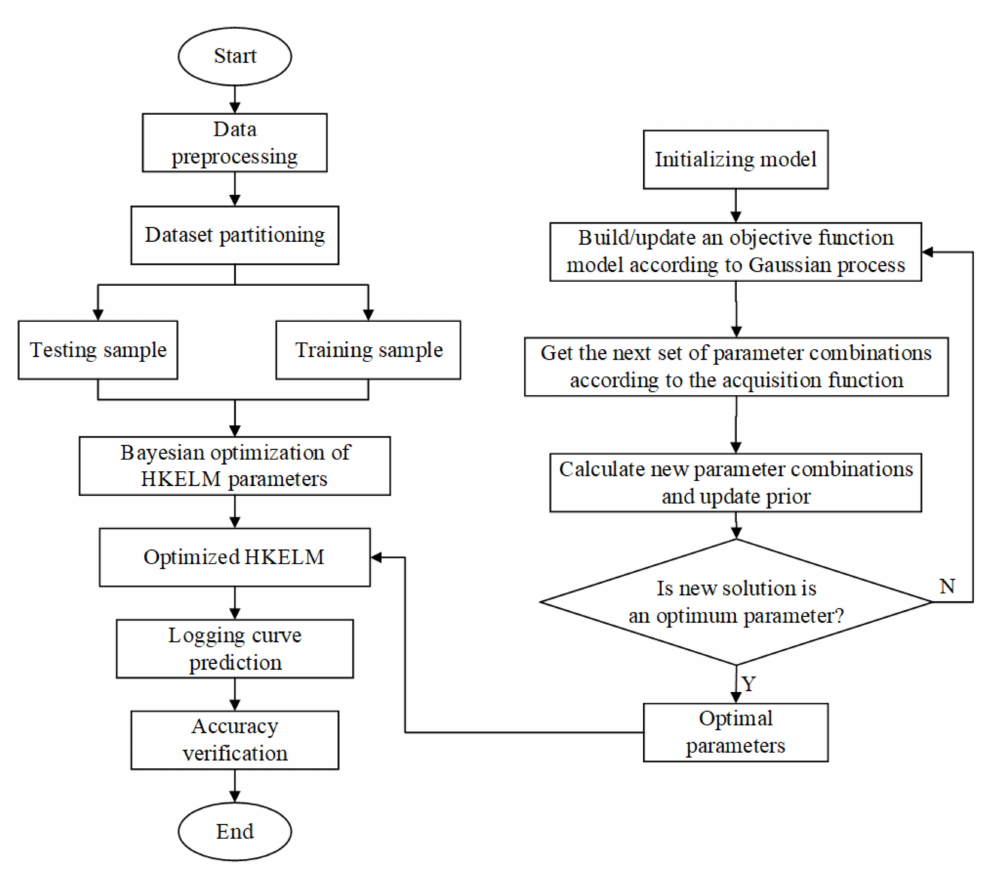
Figure 2. Flow chart of optimizing parameters of HKEM based on Bayesian